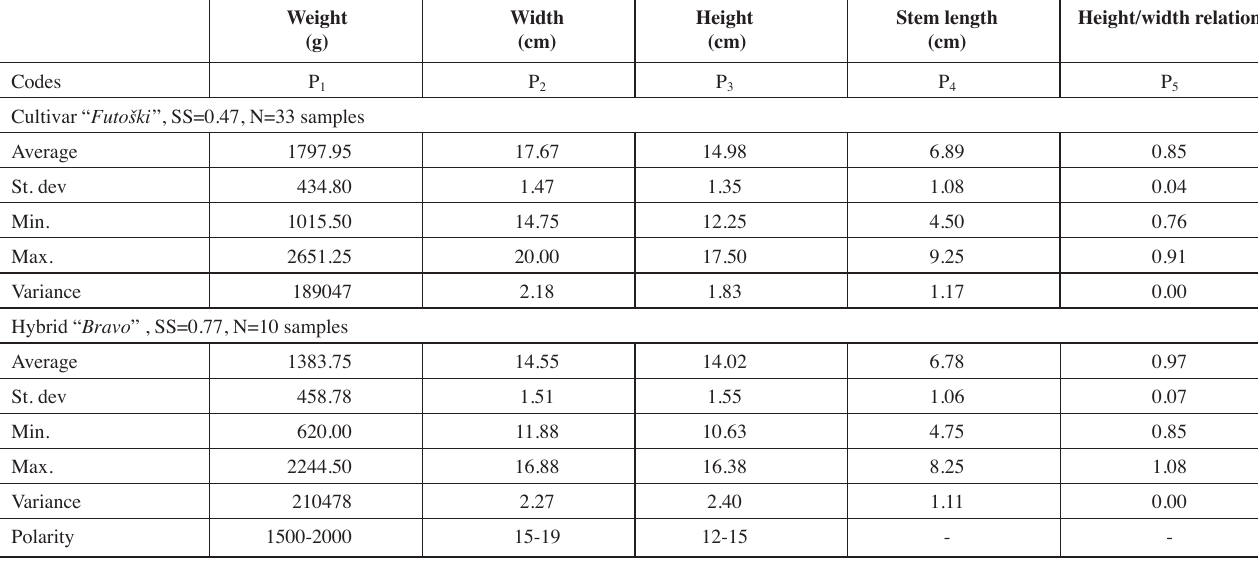
Tab. 2: Physical characteristics of raw cabbage heads, cultivar “ Futoški ” and hybrid “ Bravo